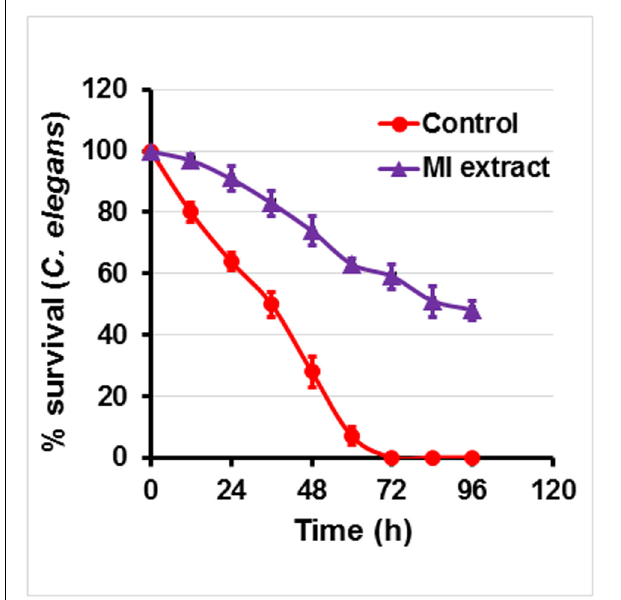
FIGURE 5 | Anti-infection potential of M. indica (methanol) extract on P. aeruginosa infected C. elegans . Figure represents effect of mango extract (800 µ g/ml) on the survival of C. elegans . Nematodes were pre-infected with P. aeruginosa and treated in the presence and absence of mango extract for 4 days. Graph represents the average of three independent experiments and SD.